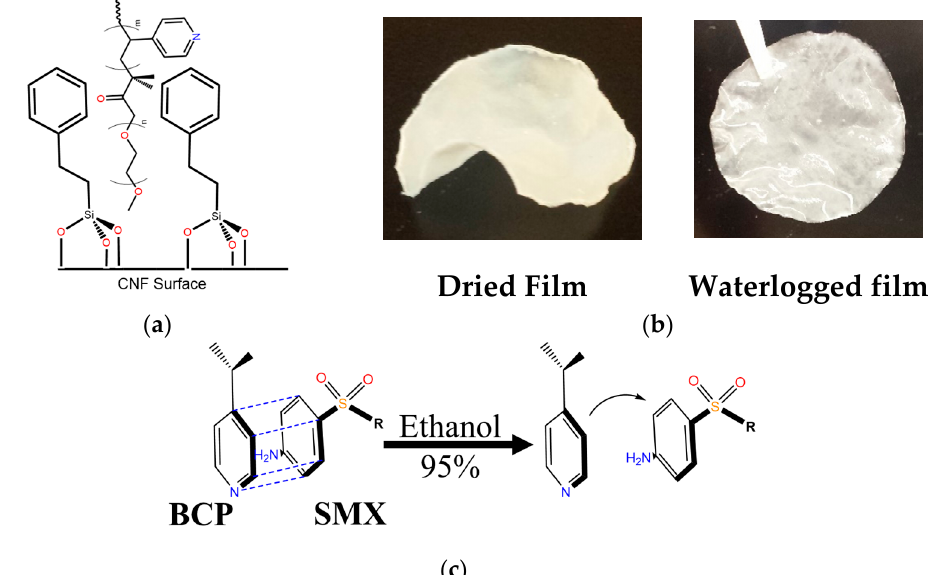
Figure 2. ( a ) Molecular structure of TMPES covalently attached to the surface of cellulose nanofibers (CNFs) showing the presence of P4VP-PEO; ( b ) photographs illustrating the dried and waterlogged CNFs films; ( c ) schematic of the electron-donor-acceptor (EDA) interaction of the pyridyl ring of P4VP-PEO with the substituted phenyl group of SMX and its elution with ethanol.